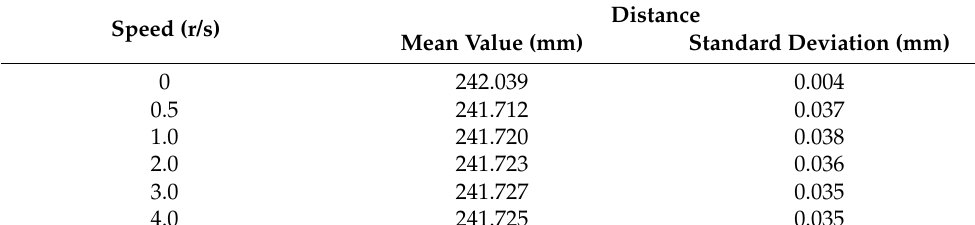
The above experimental data statistics are as follows (shown in Table 3 and Figure 17): Table 3. Measurement results of the distance between two targets at different speeds.